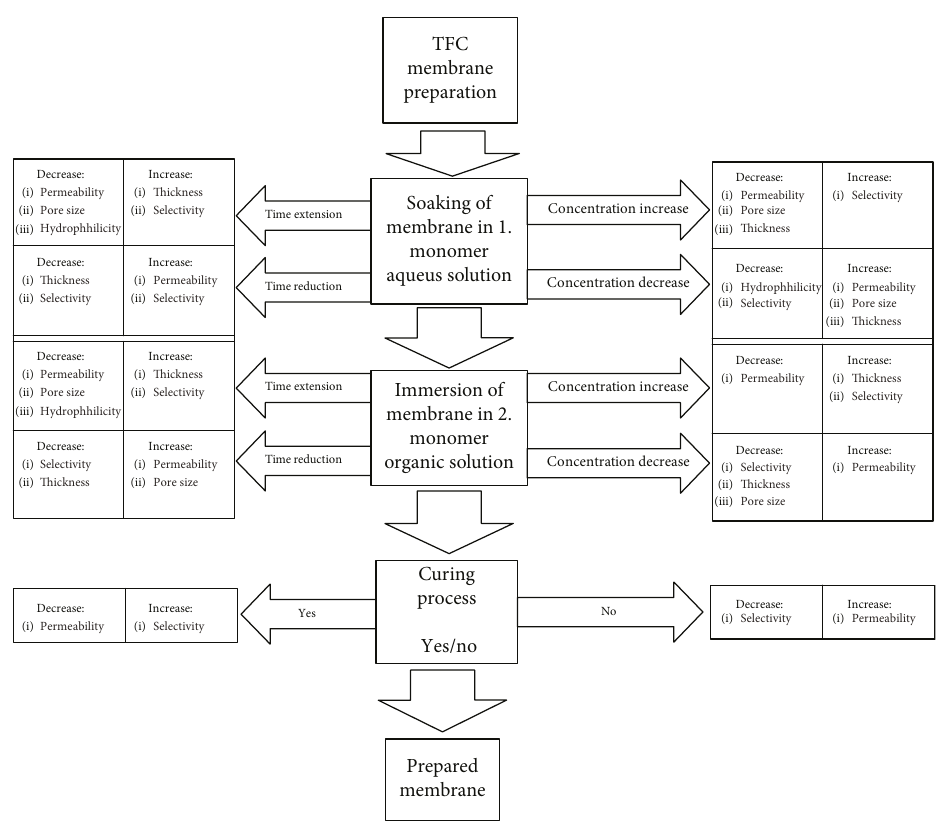
Figure 4: Flow chart of preparation of TFC membranes with general in fl uence of the most important factors: time of reaction/process, concentration of monomers, and curing temperature. First and second monomer concentrations were in ranges 1-4 wt.% and 0.1-0.2wt.%, respectively [31 –